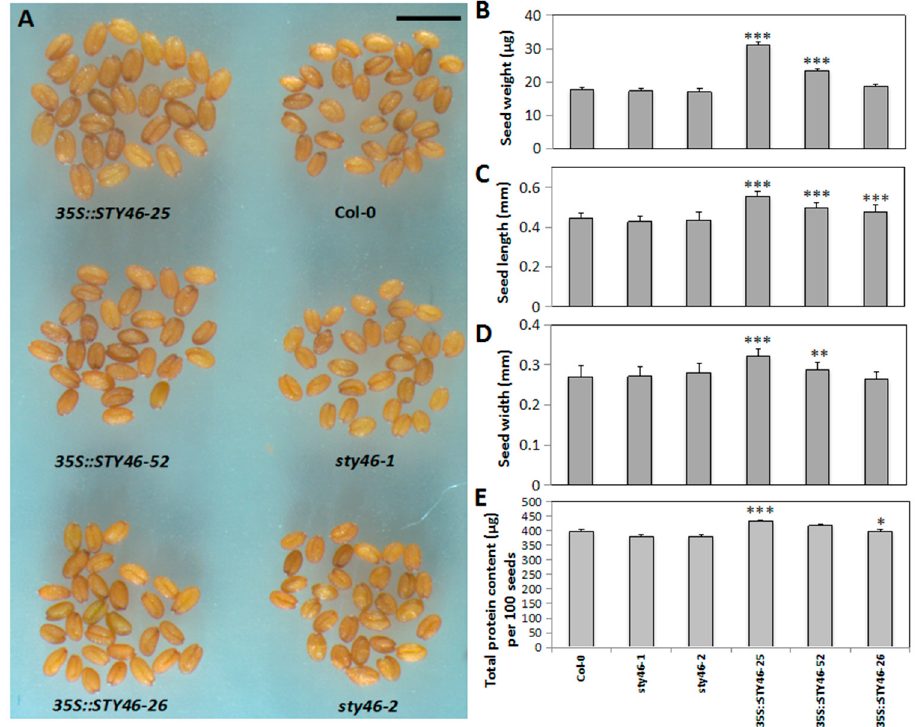
Figure 4. Characteristics of seeds harvested from the STY46 transgenic lines. Shown are ( A ) seeds as visualized under a microscope, and ( B ), seed length, ( C ) seed width, ( D ) seed weight and ( E ) total seed protein content The asterisks indicate statistically significant differences between transgenic lines and the wild type control. For ( A – C ) ( n = 30); for ( D , E ) ( n = 3) ‘*’, 0.01 < p < 0.05; ‘**’, 0.001 < p < 0.01; ‘***’, 0 < p < 0.001).